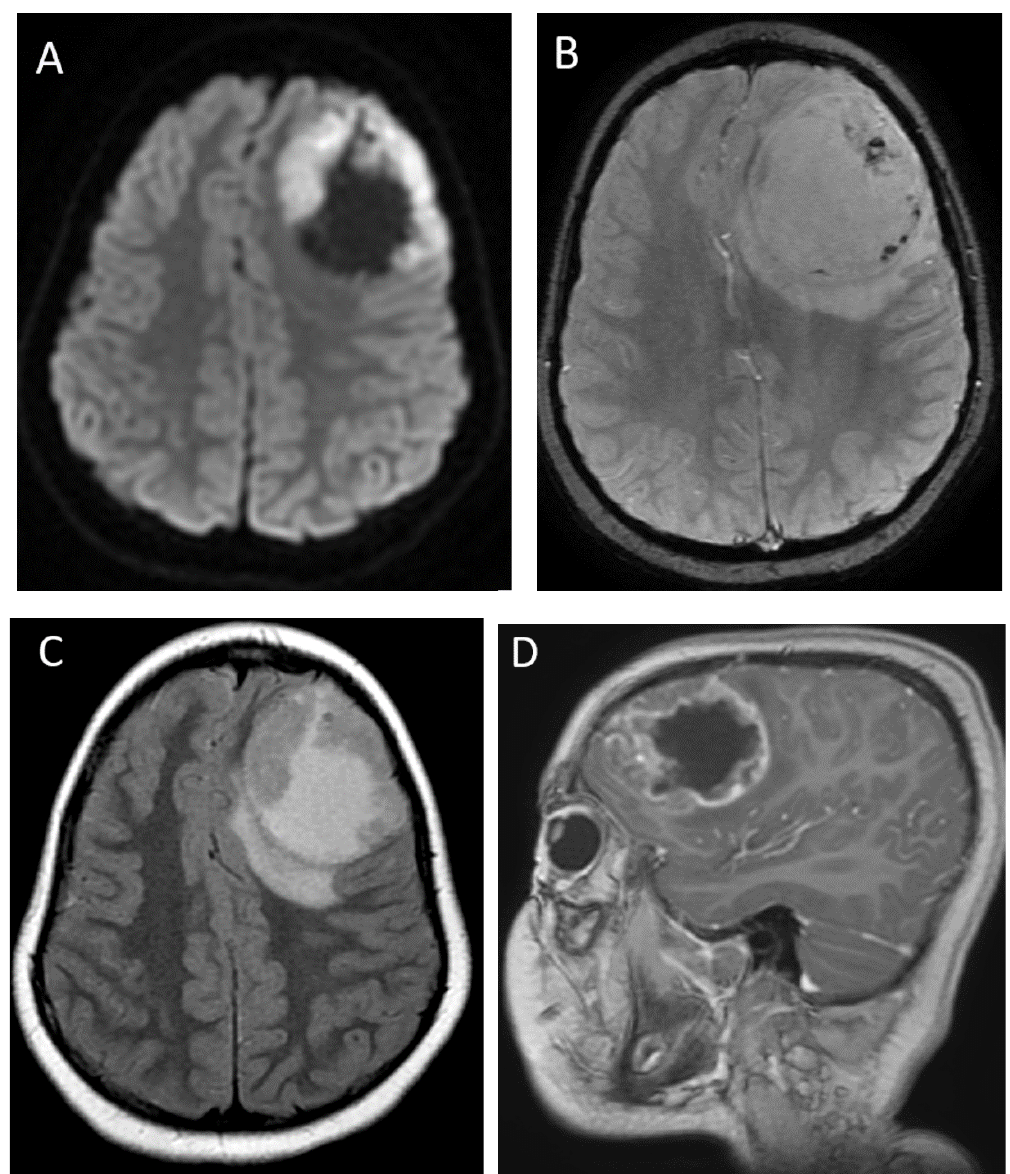
Figure 5. A 6-month-old male with CNS embryonal tumor, NOS, WHO Grade 4. Axial DWI ( A ), axial SWI ( B ), axial T2 FLAIR ( C ) and sagittal post-contrast T1-weighted ( D ) images demonstrate a